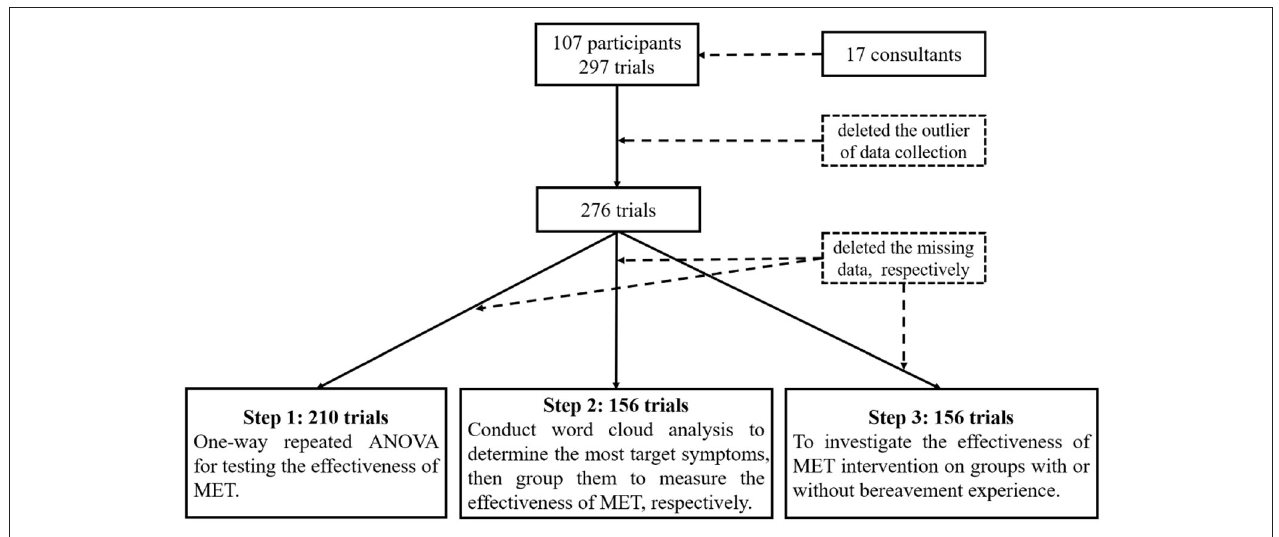
FIGURE 1 | Consort diagram for the present